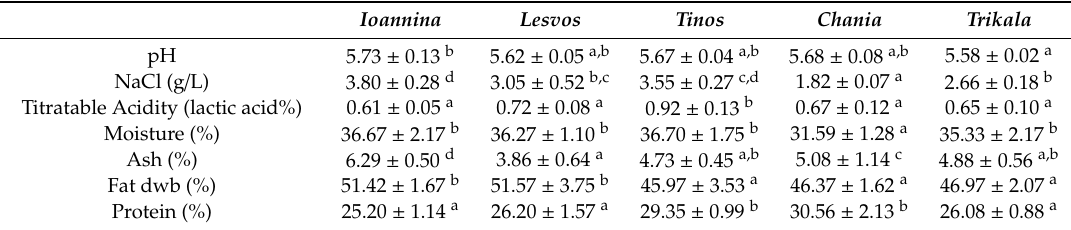
Table 1. Mean values and standard deviations (SD) of conventional quality parameters for the graviera cheese samples